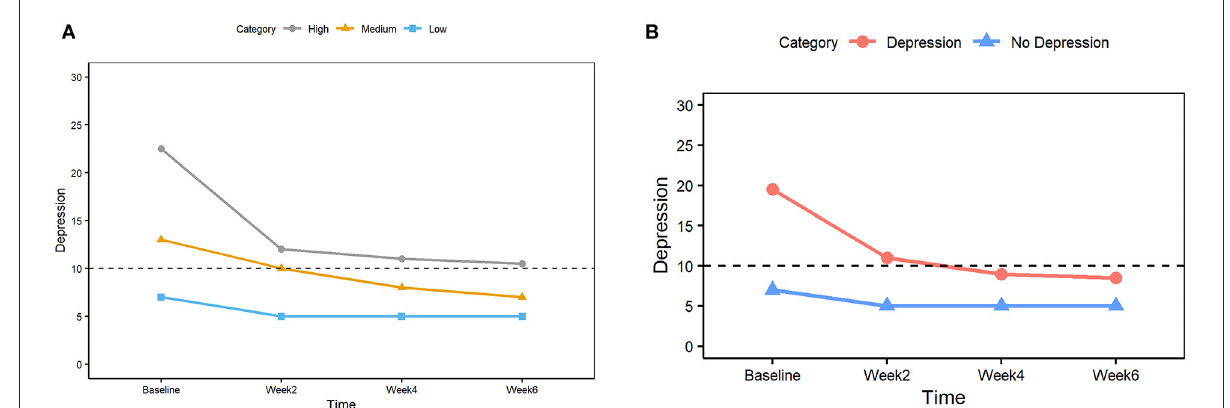
FIGURE5 (A) Median depression scores for three groups (High, Medium, and Low) based on the tertiles at the baseline. The dashed horizontal line indicates the clinically significant cutoff (score 10 or higher considered to be depression). (B) Median depression scores for two groups (Depression, No depression) based on the clinically significant cutoff of 10 at the baseline. The dashed horizontal line indicates the clinically significant cutoff (score 10 or higher considered to be depression).